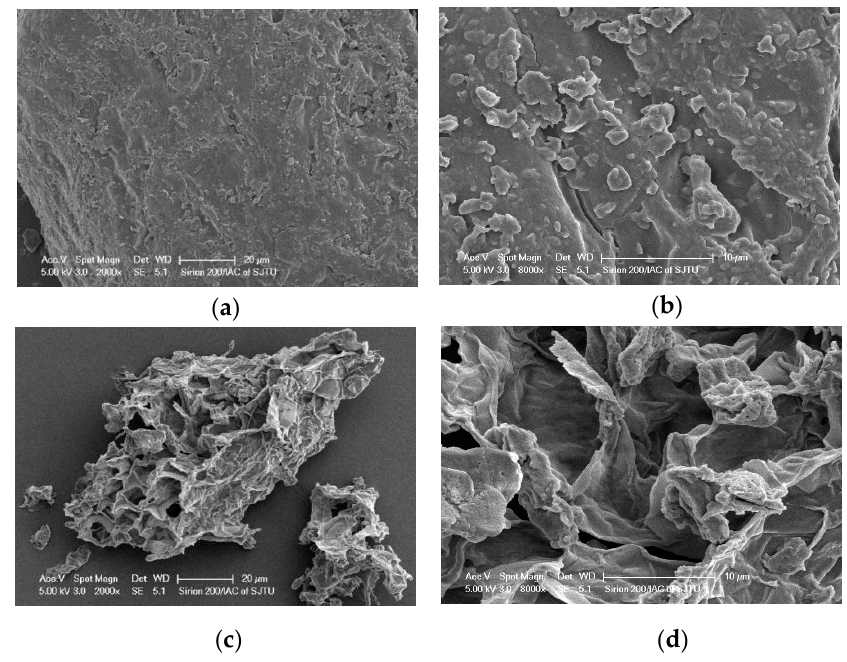
Figure 5. SEM images of the green tea powder before ( a , b ) and after ultrasonic treatment ( c , d ). Images ( a , c ) were taken at 2000× magnification, and ( b , d ) at 8000× magnification.